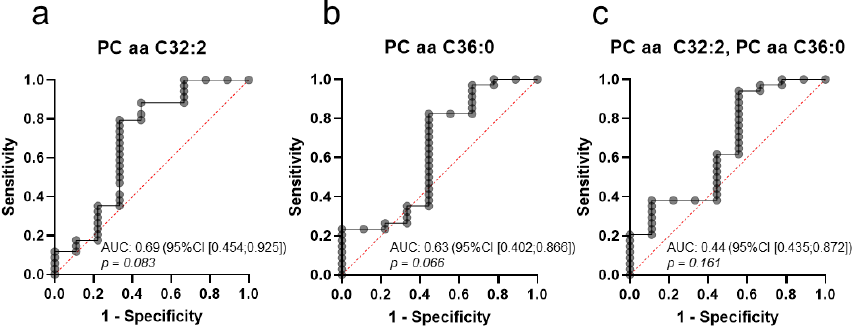
Figure A4. ROC-curves of significant metabolites (t-statistics) when comparing molecular subtype luminal B to basal-like breast cancer: ( a ) ROC of PC aa C32:2; ( b ) ROC of PC aa C36:0; and ( c ) combined graph (multiple logistic regression). Table A1. Lipid classes and single lipids detected in EV samples using the Biocrates IDQ ® p180 kit